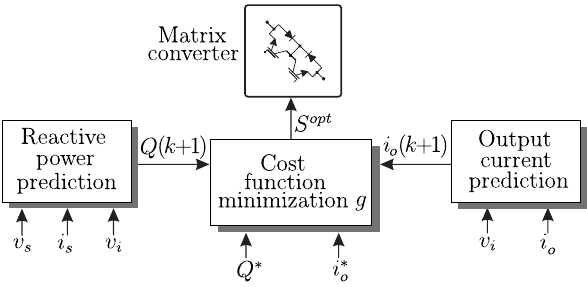
Figure 6. Predictive current control with reactive power minimization block